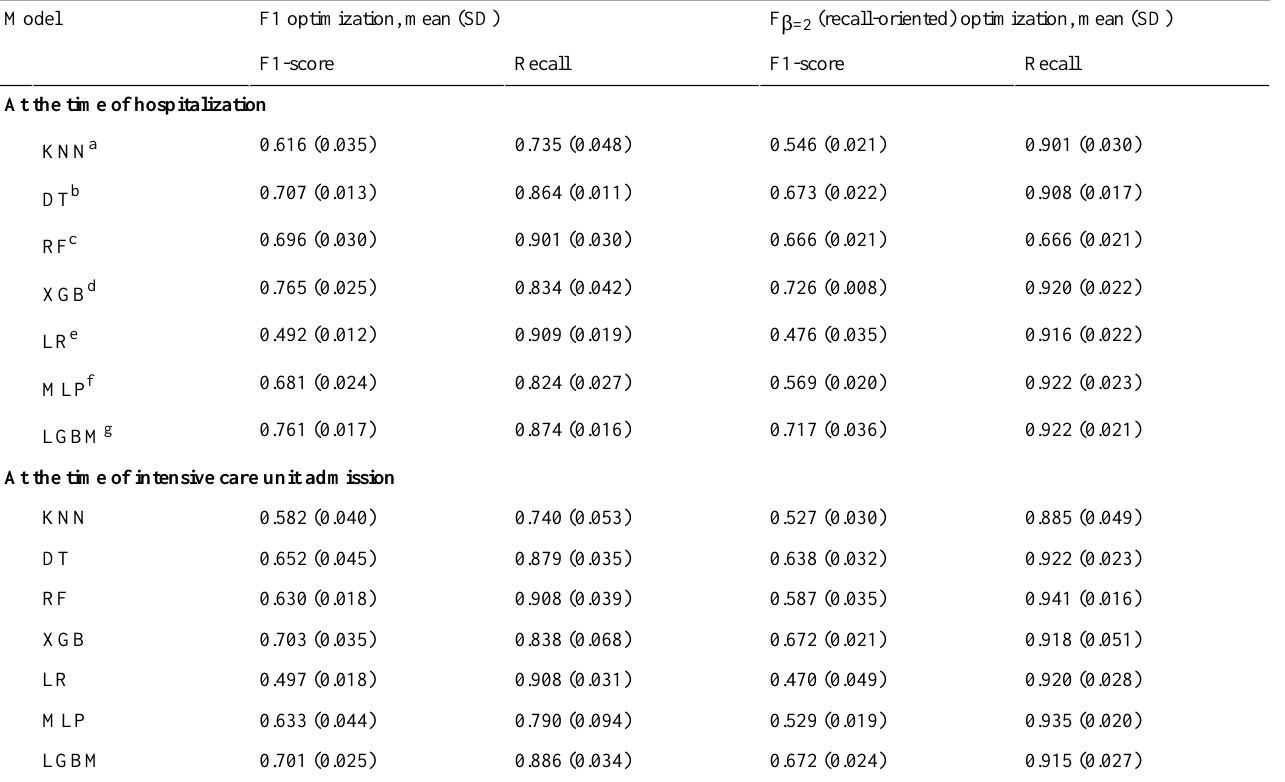
Table 5. Predictability of survivability per predictive